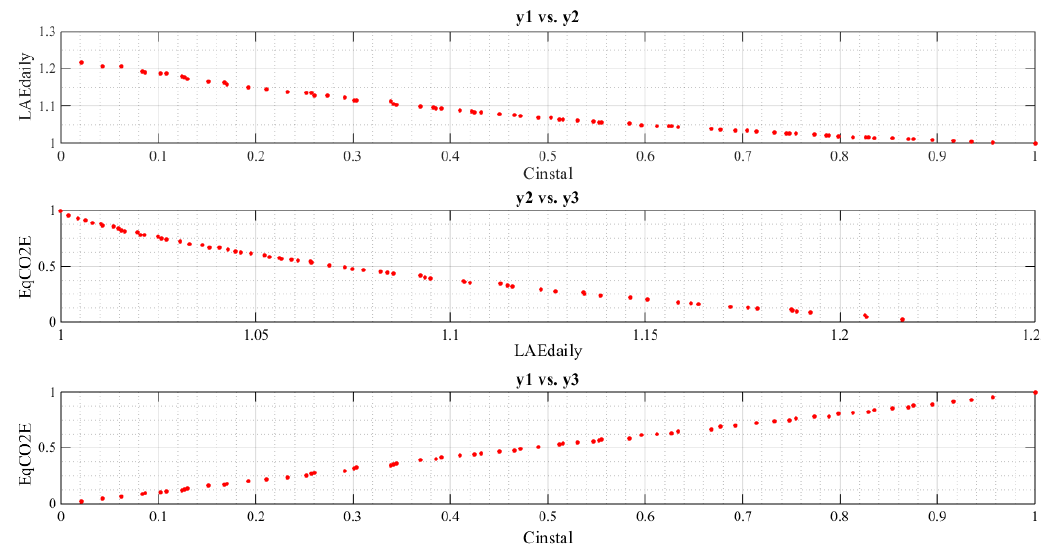
Figure 7. Graphic comparison among objective functions for conflict checking—case-study II. Phenotypes of solution alternatives based on decision criteria are shown in Table 4, where MAR = 15% and energy price 0.15 $/kWh are adopted in maximum NPV criterion. based on minimum losses and maximum net present value criteria reflects an agreement of goals to both DisCo and DG owner, since higher production of energy implies in lower losses to the DisCo seeking of efficiency while it results in higher sales and shorter payback time to the DG owner. The comparatively lower number of generation modules regarding the solution for the Max-Min approximation criterion reflects again the need for tradeoffs among conflicting goals in such a way as to ensure success in the decision- making process. The solution based on both minimum losses and maximum NPV criteria presents daily active power losses 𝐿𝐴𝐸 (cid:3031)(cid:3028)(cid:3036)(cid:3039)(cid:3052) = 3.42 MWh at an installation cost of 5.57 × 10 6 USD and net benefit of 0.99 × 10 6 USD, resulting in a power loss reduction of 17.8% in comparison to the case with no dispersed generation ( 𝐿𝐴𝐸 (cid:3031)(cid:3028)(cid:3036)(cid:3039)(cid:3052) = 4.16 MWh). When DG is owned by the DisCo, 𝐿𝐴𝐸 (cid:3031)(cid:3028)(cid:3052)(cid:3039)(cid:3052) can also be converted in USD based on the same energy price and MAR as interest rate, which would result in savings of 4.88 × 10 6 USD to the DisCo. MMA decision criterion results in daily active power losses ( 𝐿𝐴𝐸 (cid:3031)(cid:3028)(cid:3036)(cid:3039)(cid:3052) ) of 3.72 MWh, corresponding with 10.6% of power loss reduction. In this case, the DisCo savings are 2.9 × 10 6 USD compared to the case with no dispersed generation. The solution obtained through MMA represents approximately 50% of equivalent CO 2 emission and 59% of installation cost compared to the minimum losses and maximum NPV criteria. It is important to mention that MMA criterion suggests installation of PV-02 type, since it is technologically superior, producing better results, even at a higher price. Thus, it can be concluded over again that MMA can be adopted as a non-preference decision criterion to satisfy varied perspectives of concern.